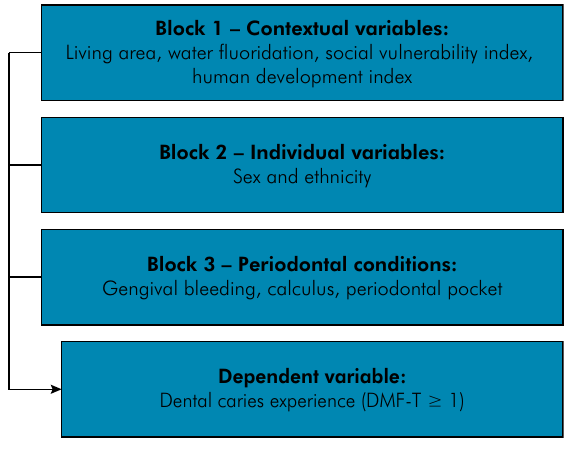
Figure 1. Conceptual theoretical model for the study of the association between caries experience in a population of 12-year-old children and independent variables subdivided into contextual, individual and periodontal